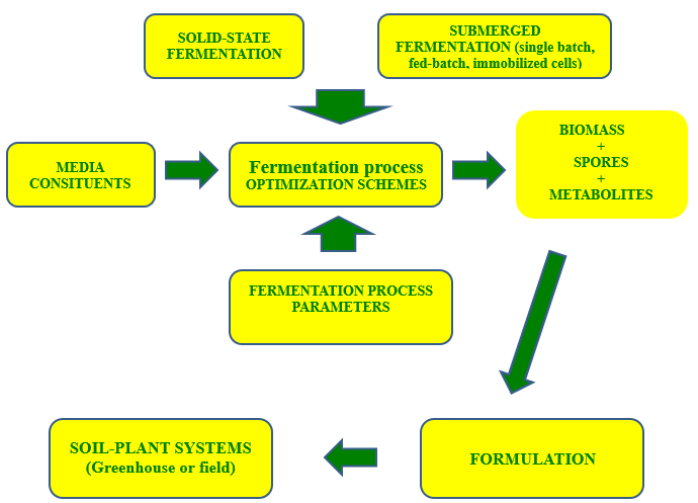
Figure 1. General scheme of submerged and solid-state-fermentation-based production of bioformulates.